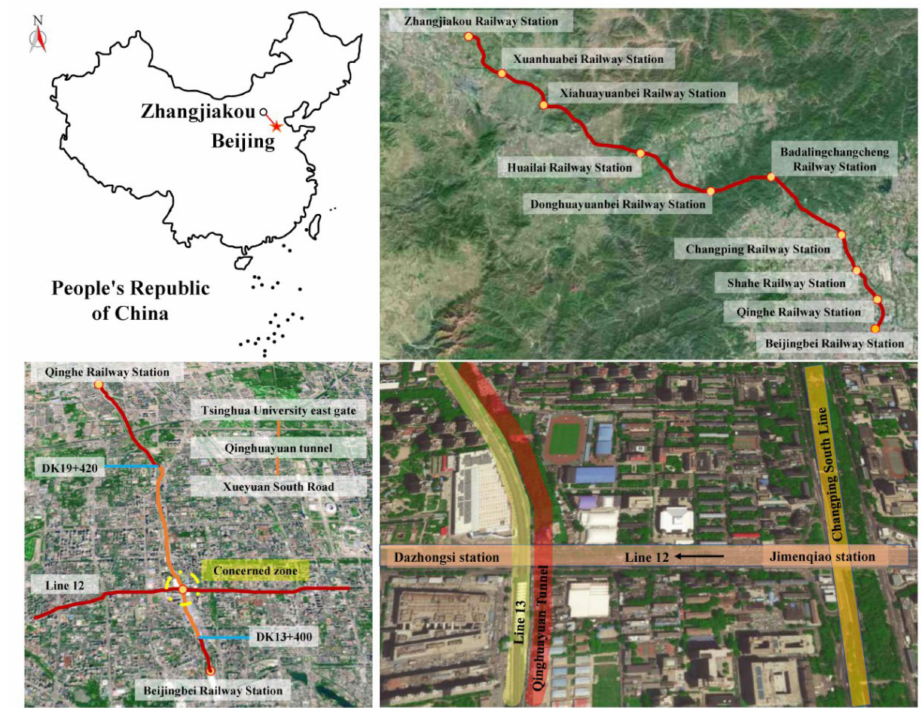
Figure 1. Views of Jing-Zhang High-speed Railway, Qinghuayuan Tunnel, and Subway Line